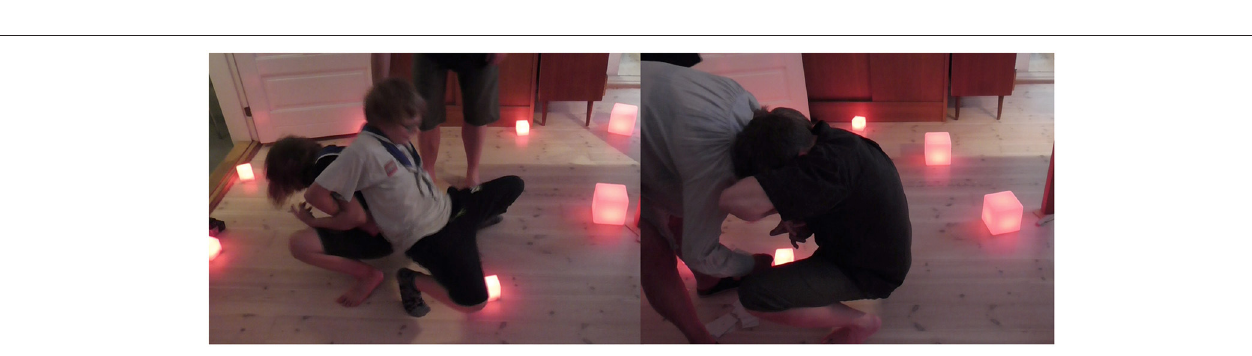
FIGURE 3 | Left image: Mom, daughter and cat playing together. Mom and daughter’s hands are glued to each other, right image: Mom and daughter playing Keep the Music Going.